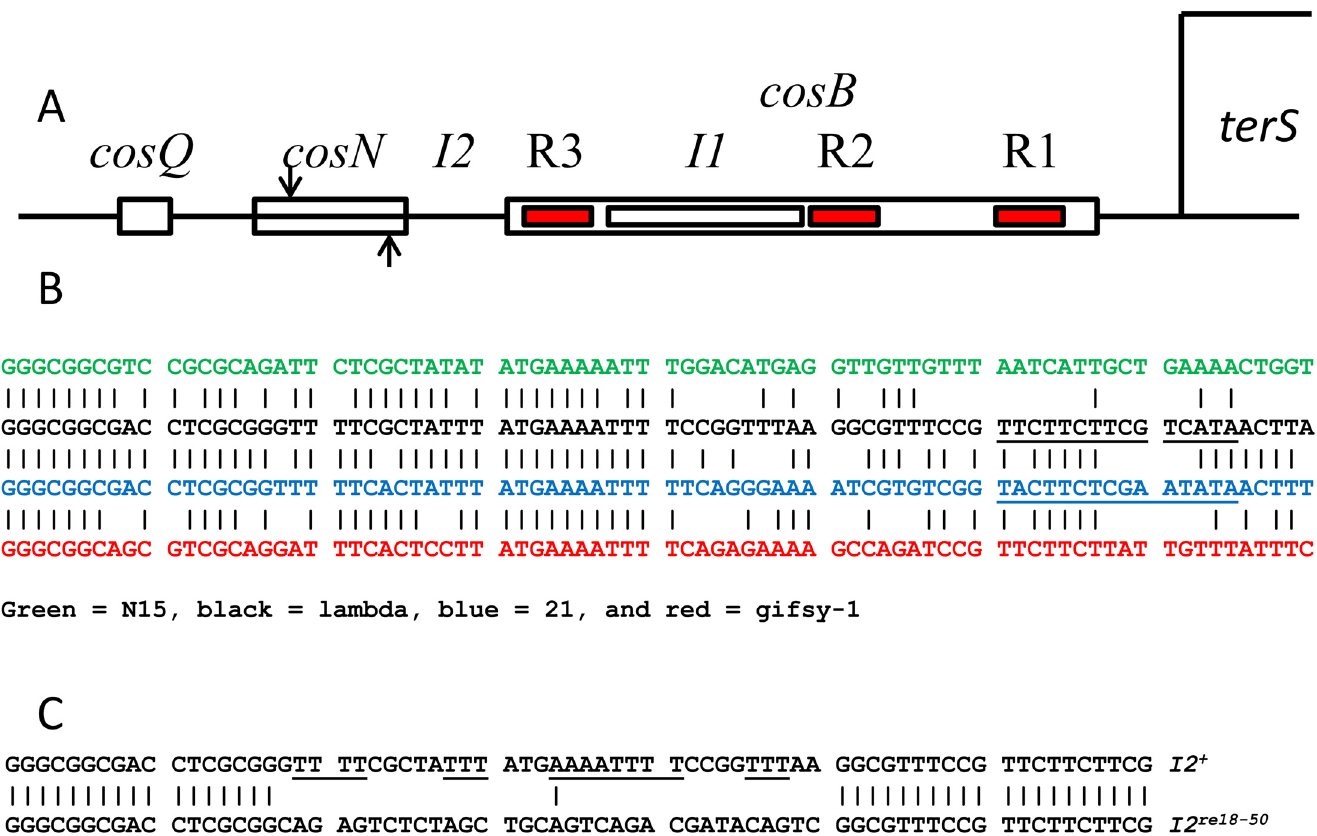
Fig 1. Elements of cos . A. Structure of cos λ . cosN is the site at which TerL endonuclease centers introduce staggered nicks to generate the cohesive ends of λ virion DNA. cosB is the complex site at which TerS binds to anchor TerL: R3, R2 and R1 are TerS binding sites, and I1 is a binding site for the E . coli site-specific DNA bending protein, IHF. I2 is located between cosN and cosB . cosQ is essential for DNA packaging termination. B. Alignment of the I2 -containing left DNA ends, i.e., bp 1 – 70, of λ -like phages N15 (green), λ (black), 21 (blue) and gifsy-1 (red). The I2 segment extends approximately from bp 18 to 50. Approximate positions of R3 segments are underlined. C. The sequence of the left DNA end, bp 1 – 70, of I2 + (above) and I2 re18-50 (below). The I2 re18-50 mutation replaces the AT-rich I2 + sequence without changing the cosN-cosB spacing. Underlining highlights the poly-dA and poly-dT segments of I2 +